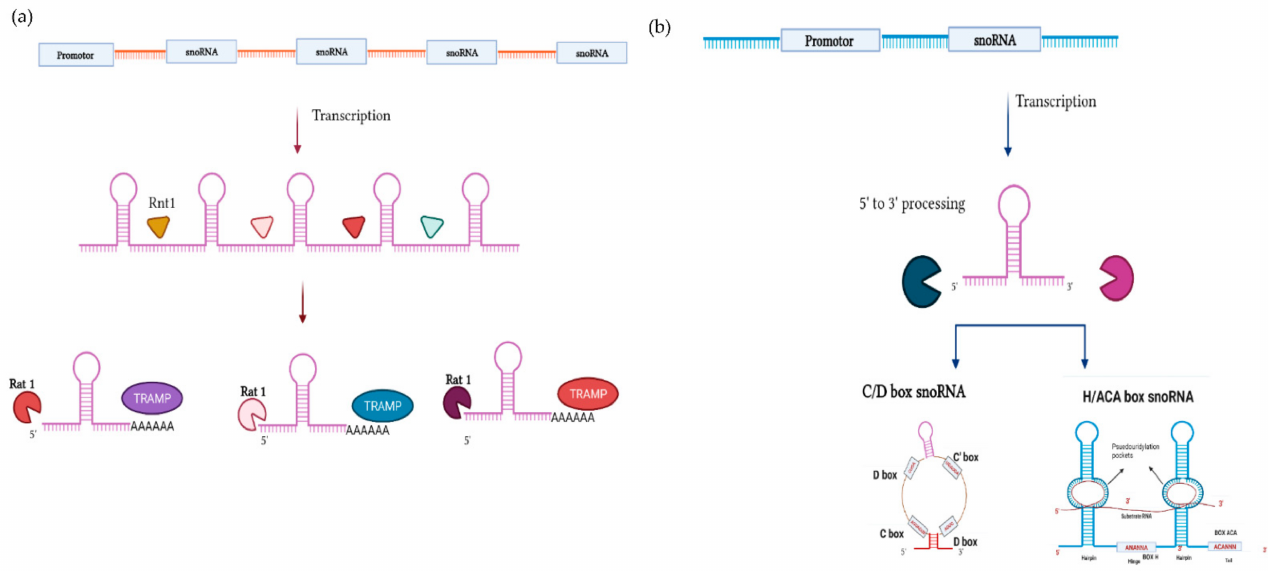
Figure 4. Production of snoRNAs from polycistronic transcriptions and from independently transcribed genes: ( a ) Only a few snoRNAs in yeast are transcribed polycistronically—an example of which are the seven C/D box snoRNA transcribed polycistronically from the cluster located on chromosome 8. The snoRNAs are transcribed as a single transcript from an independent promotor with no intervening exons present in between. The snoRNAs are processed by the nucleases Rnt1 and Rat1. Rnt1P facilitates the removal of m7G cap and cleaves the transcript at Rnt1 cleavage sites such that an entry site for the exonucleases is created for the further processing of pre-snoRNAs. Almost all SNORDs are synthesized having capped 5 (cid:48) extensions; however, the uncapped 5 (cid:48) extensions are processed by Rat1p and Xrn1p. Additionally, the 3 (cid:48) processing is performed by TRAMP4/5 and Rrp6 [63,64]. Rnt1-dependent 5 (cid:48) processing of snoRNAs is critical for its function [65]. ( b ) Some of the snoRNAs in yeast are transcribed monocistronically, having an independent promotor. This type of snoRNA is released from the intergenic parent via endonucleolytic cleavage followed by processing by 5 (cid:48) to 3 (cid:48)